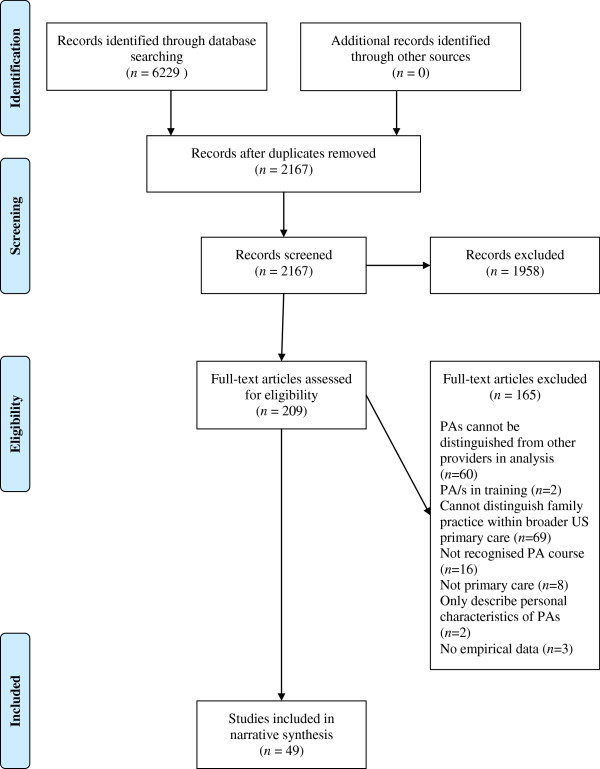
PRISMA flowchart.